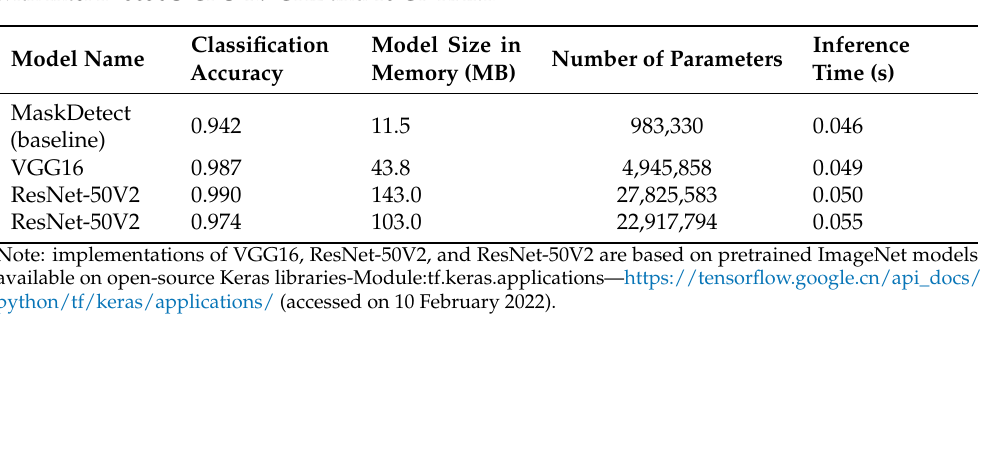
Table 1. Comparative performance analysis of various models on a desktop computational platform with Intel I7-8650U CPU 1.9 GHz and 16 GB